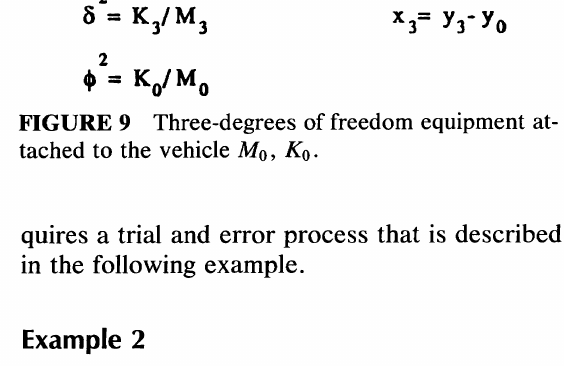
FIGURE 8 Shock response spectra for Designs 1 and 2.